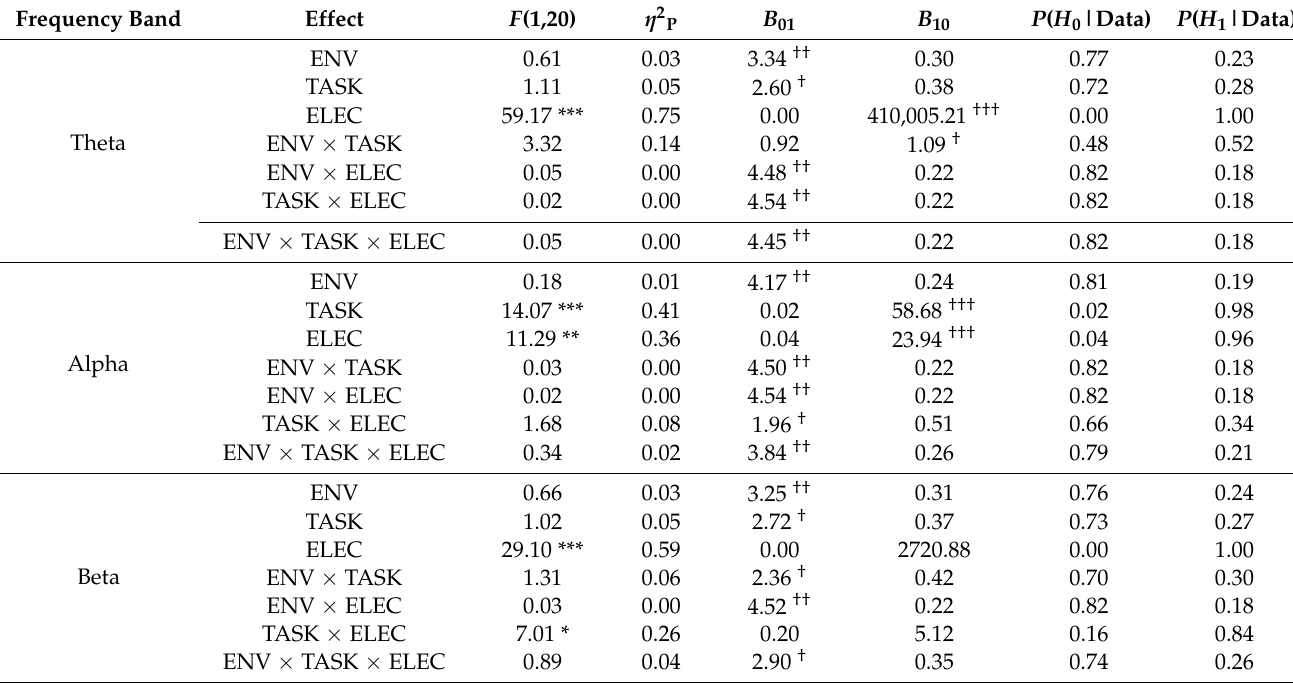
Table 5. Analysis of variance (ANOVA) for PASAT versus Resting Task Eyes Open EEG power. Frequency